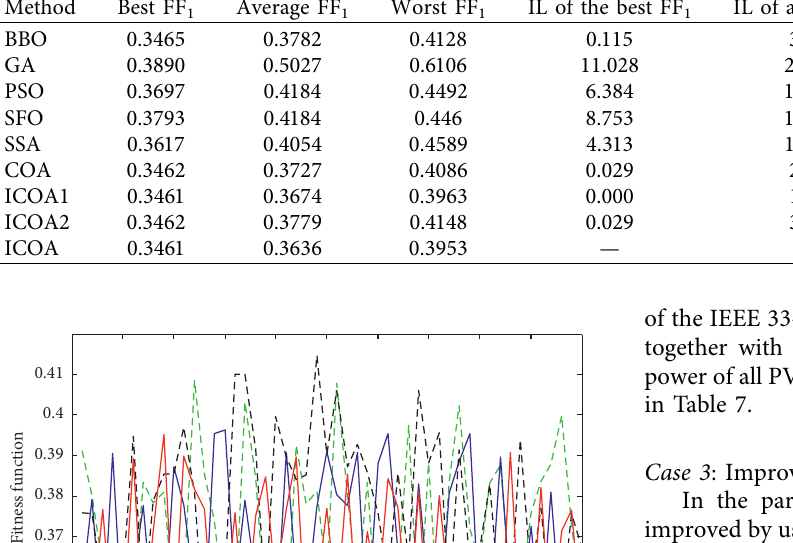
Table 4: The comparison among nine methods of the IEEE 33-bus distribution network for the first case. Method